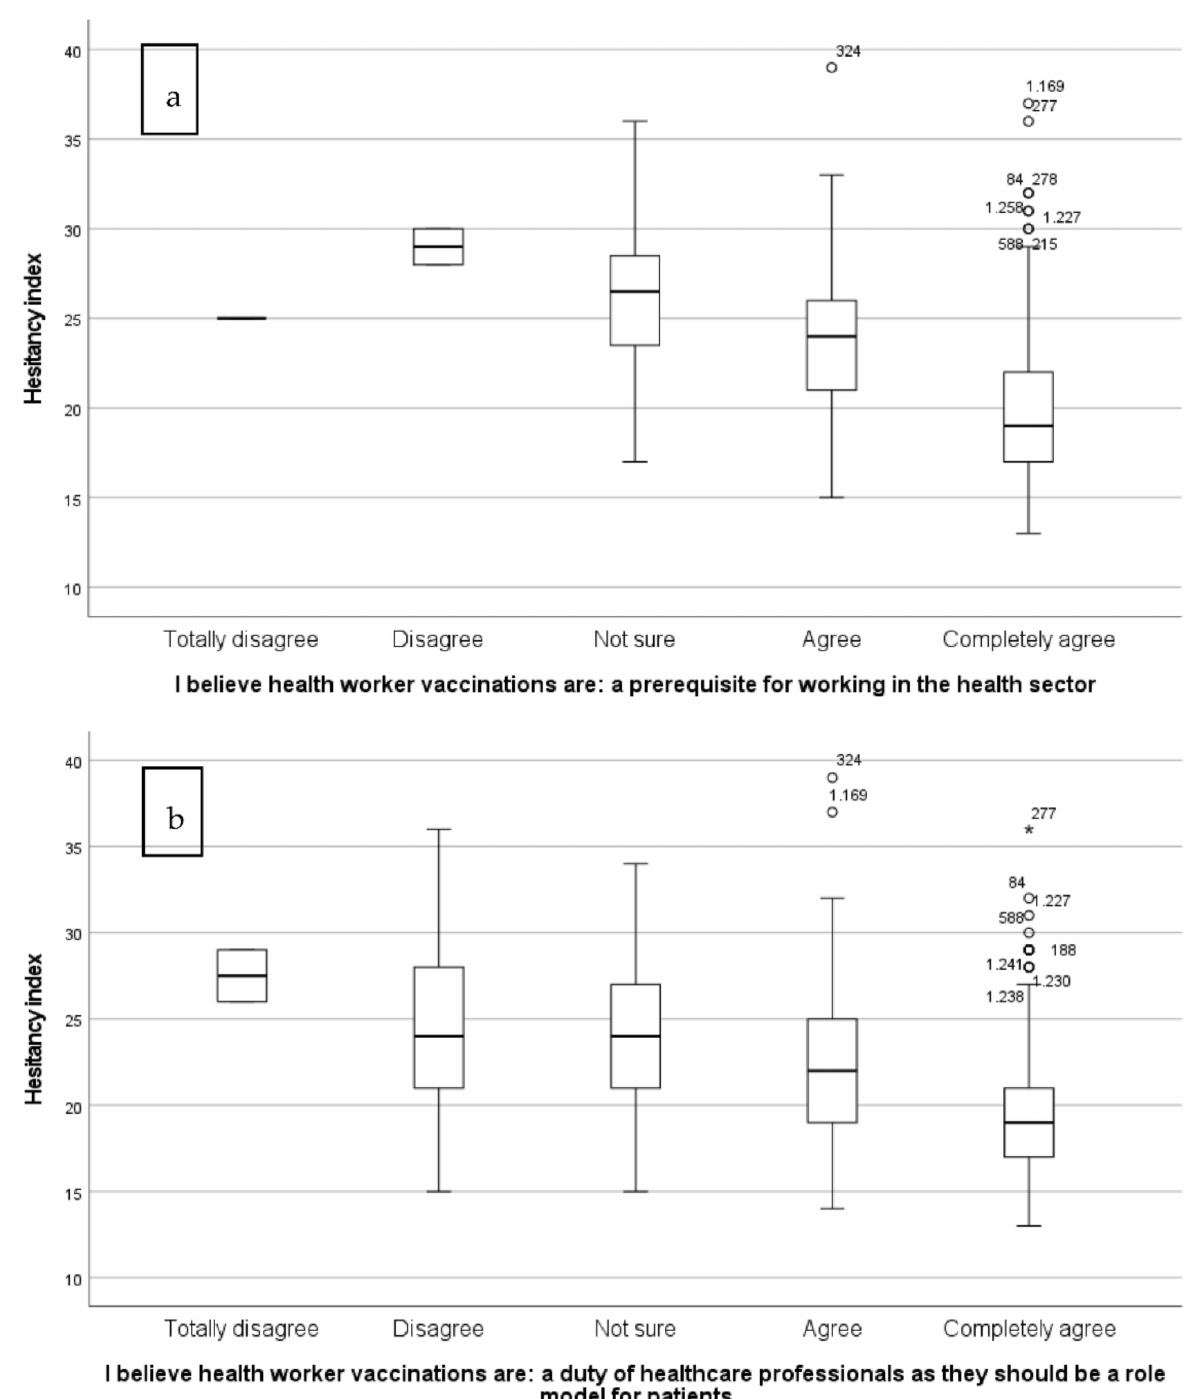
Figure 1. VH index distribution by the opinion of healthcare professionals toward